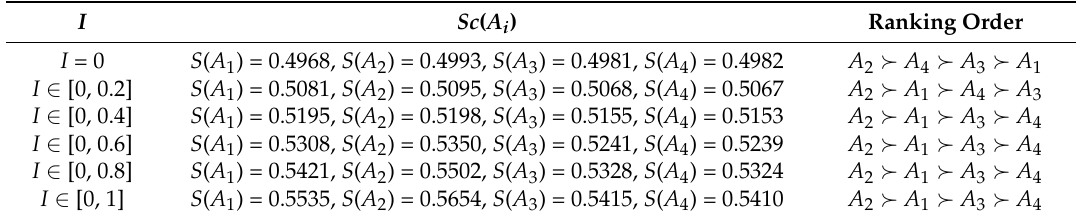
Table 2. Sensitivity analysis and ranking order with variation of “ I ” on NNs for strategy 2.